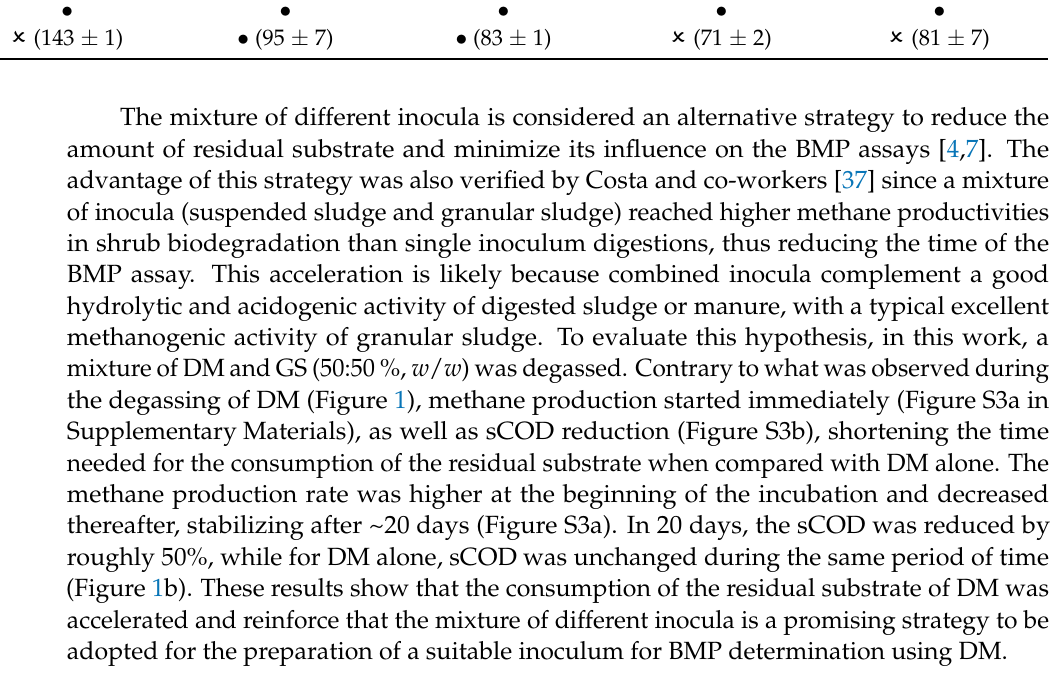
Table 4. BMP values (L kg − 1 ) of crystalline cellulose using fresh dairy manure (DM) and degassed Table 2. BMP values (L ∙ kg − 1 ) of crystalline cellulose using digested sewage sludge (DSS) or Table 2. BMP values (L ∙ kg − 1 ) of crystalline cellulose using digested sewage sludge (DSS) or Table 2. BMP values (L ∙ kg − 1 ) of crystalline cellulose using digested sewage sludge (DSS) or Table 2. BMP values (L ∙ kg − 1 ) of crystalline cellulose using digested sewage sludge (DSS) or DM (dDM) as inoculum, before and after subtracting the methane produced in the different blanks degassed DSS (dDSS) as inocula, before and after subtracting the methane produced in the different degassed DSS (dDSS) as inocula, before and after subtracting the methane produced in the different degassed DSS (dDSS) as inocula, before and after subtracting the methane produced in the different degassed DSS (dDSS) as inocula, before and after subtracting the methane produced in the different (Hv Wv − 1 : 0.6, 2.3, 5.0 and 10.1). The corresponding % of the theoretical BMP max is shown between Table 2. BMP values (L ∙ kg − 1 ) of crystalline cellulose using digested sewage sludge (DSS) or Table 2. BMP values (L ∙ kg − 1 ) of crystalline cellulose using digested sewage sludge (DSS) or Table 2. BMP values (L ∙ kg − 1 ) of crystalline cellulose using digested sewage sludge (DSS) or Table 2. BMP values (L ∙ kg − 1 ) of crystalline cellulose using digested sewage sludge (DSS) or Table 2. BMP values (L ∙ kg − 1 ) of crystalline cellulose using digested sewage sludge (DSS) or blanks (Hv ∙ Wv − 1 of 0.6, 2.3, 5.0 and 10.1). The corresponding % of the theoretical BMP max is shown blanks (Hv ∙ Wv − 1 of 0.6, 2.3, 5.0 and 10.1). The corresponding % of the theoretical BMP max is shown blanks (Hv ∙ Wv − 1 of 0.6, 2.3, 5.0 and 10.1). The corresponding % of the theoretical BMP max is shown blanks (Hv ∙ Wv − 1 of 0.6, 2.3, 5.0 and 10.1). The corresponding % of the theoretical BMP max is shown degassed DSS (dDSS) as inocula, before and after subtracting the methane produced in the different degassed DSS (dDSS) as inocula, before and after subtracting the methane produced in the different degassed DSS (dDSS) as inocula, before and after subtracting the methane produced in the different degassed DSS (dDSS) as inocula, before and after subtracting the methane produced in the different degassed DSS (dDSS) as inocula, before and after subtracting the methane produced in the different between brackets in BMP_Control (%). The ful fi llment ( ● ) or not (  ) of the proposed validation between brackets in BMP_Control (%). The ful fi llment ( ● ) or not (  ) of the proposed validation between brackets in BMP_Control (%). The ful fi llment ( ● ) or not (  ) of the proposed validation between brackets in BMP_Control (%). The ful fi llment ( ● ) or not (  ) of the proposed validation blanks (Hv ∙ Wv − 1 of 0.6, 2.3, 5.0 and 10.1). The corresponding % of the theoretical BMP max is shown blanks (Hv ∙ Wv − 1 of 0.6, 2.3, 5.0 and 10.1). The corresponding % of the theoretical BMP max is shown blanks (Hv ∙ Wv − 1 of 0.6, 2.3, 5.0 and 10.1). The corresponding % of the theoretical BMP max is shown blanks (Hv ∙ Wv − 1 of 0.6, 2.3, 5.0 and 10.1). The corresponding % of the theoretical BMP max is shown blanks (Hv ∙ Wv − 1 of 0.6, 2.3, 5.0 and 10.1). The corresponding % of the theoretical BMP max is shown Table 2. BMP values (L ∙ kg − 1 ) of crystalline cellulose using digested sewage sludge (DSS) or Table 2. BMP values (L ∙ kg − 1 ) of crystalline cellulose using digested sewage sludge (DSS) or Table 2. BMP values (L ∙ kg − 1 ) of crystalline cellulose using digested sewage sludge (DSS) or Table 2. BMP values (L ∙ kg − 1 ) of crystalline cellulose using digested sewage sludge (DSS) or between brackets in BMP_Control (%). The ful fi llment ( ● ) or not (  ) of the proposed validation between brackets in BMP_Control (%). The ful fi llment ( ● ) or not (  ) of the proposed validation between brackets in BMP_Control (%). The ful fi llment ( ● ) or not (  ) of the proposed validation between brackets in BMP_Control (%). The ful fi llment ( ● ) or not (  ) of the proposed validation between brackets in BMP_Control (%). The ful fi llment ( ● ) or not (  ) of the proposed validation degassed DSS (dDSS) as inocula, before and after subtracting the methane produced in the different degassed DSS (dDSS) as inocula, before and after subtracting the methane produced in the different degassed DSS (dDSS) as inocula, before and after subtracting the methane produced in the different degassed DSS (dDSS) as inocula, before and after subtracting the methane produced in the different criteria ( CH 4 _Blk < 20%, RDS < 6% and BMP_Control ) is also shown. criteria ( CH 4 _Blk < 20%, RDS < 6% and BMP_Control ) is also shown. criteria ( CH 4 _Blk < 20%, RDS < 6% and BMP_Control ) is also shown. Table 2. BMP values (L ∙ kg − 1 ) of crystalline cellulose using digested sewage sludge (DSS) or Table 2. BMP values (L ∙ kg − 1 ) of crystalline cellulose using digested sewage sludge (DSS) or Table 2. BMP values (L ∙ kg − 1 ) of crystalline cellulose using digested sewage sludge (DSS) or blanks (Hv ∙ Wv − 1 of 0.6, 2.3, 5.0 and 10.1). The corresponding % of the theoretical BMP max is shown blanks (Hv ∙ Wv − 1 of 0.6, 2.3, 5.0 and 10.1). The corresponding % of the theoretical BMP max is shown blanks (Hv ∙ Wv − 1 of 0.6, 2.3, 5.0 and 10.1). The corresponding % of the theoretical BMP max is shown blanks (Hv ∙ Wv − 1 of 0.6, 2.3, 5.0 and 10.1). The corresponding % of the theoretical BMP max is shown degassed DSS (dDSS) as inocula, before and after subtracting the methane produced in the different degassed DSS (dDSS) as inocula, before and after subtracting the methane produced in the different degassed DSS (dDSS) as inocula, before and after subtracting the methane produced in the different between brackets in BMP_Control (%). The ful fi llment ( ● ) or not (  ) of the proposed validation between brackets in BMP_Control (%). The ful fi llment ( ● ) or not (  ) of the proposed validation between brackets in BMP_Control (%). The ful fi llment ( ● ) or not (  ) of the proposed validation between brackets in BMP_Control (%). The ful fi llment ( ● ) or not (  ) of the proposed validation blanks (Hv ∙ Wv − 1 of 0.6, 2.3, 5.0 and 10.1). The corresponding % of the theoretical BMP max is shown blanks (Hv ∙ Wv − 1 of 0.6, 2.3, 5.0 and 10.1). The corresponding % of the theoretical BMP max is shown blanks (Hv ∙ Wv − 1 of 0.6, 2.3, 5.0 and 10.1). The corresponding % of the theoretical BMP max is shown criteria ( CH 4 _Blk < 20%, RDS < 6% and BMP_Control ) is also shown. criteria ( CH 4 _Blk < 20%, RDS < 6% and BMP_Control ) is also shown. criteria ( CH 4 _Blk < 20%, RDS < 6% and BMP_Control ) is also shown. between brackets in BMP_Control (%). The ful fi llment ( ● ) or not (  ) of the proposed validation between brackets in BMP_Control (%). The ful fi llment ( ● ) or not (  ) of the proposed validation between brackets in BMP_Control (%). The ful fi llment ( ● ) or not (  ) of the proposed validation criteria ( CH 4 _Blk < 20%, RDS < 6% and BMP_Control ) is also shown. criteria ( CH 4 _Blk < 20%, RDS < 6% and BMP_Control ) is also